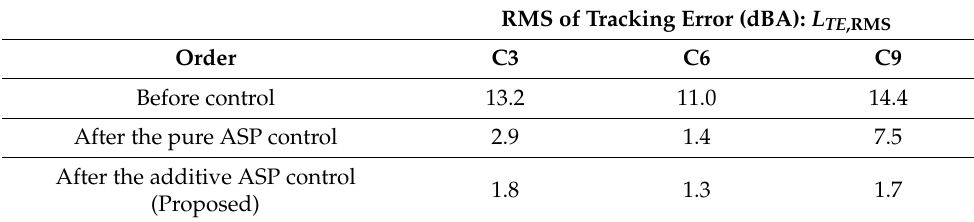
Table 3. Summary of the tracking performances of the pure and additive algorithms for the C3, C6, and C9